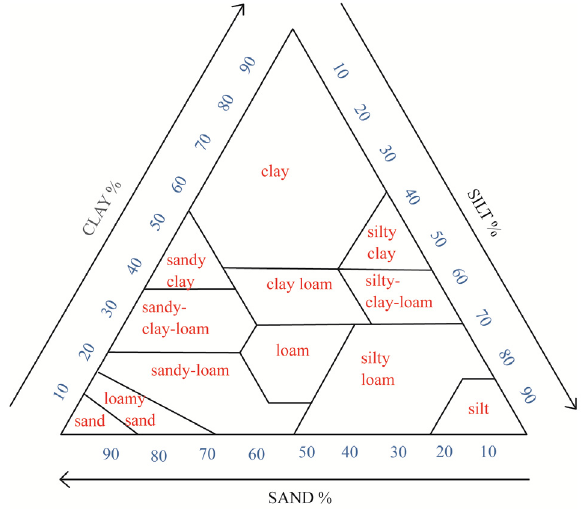
Figure 2. USDA (United States Departement of Agriculture) tex- tures